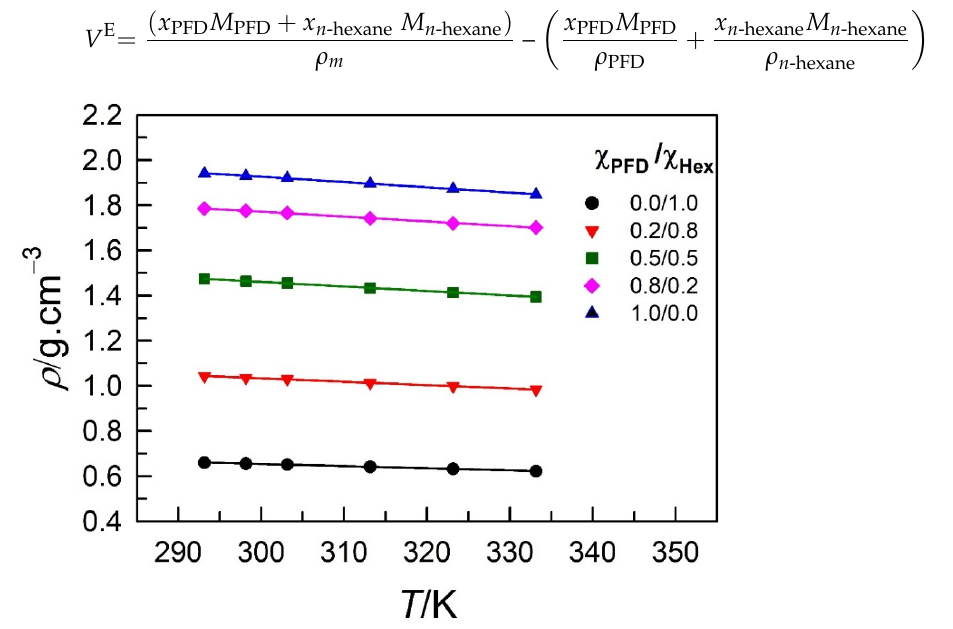
Figure 2. Variation in densities of the investigated mixtures with temperature at different mole fraction ratios and at pressure p = 0.1 MPa. The solid line represents fit to the equation 𝜌 /(g ∙ cm − 3 ) = 𝜌 o,T /(g ∙ cm − 3 ) + 𝑎 ( T /K). Parameters 𝜌 o,T and 𝑎 , along with R 2 are provided in Table 2.